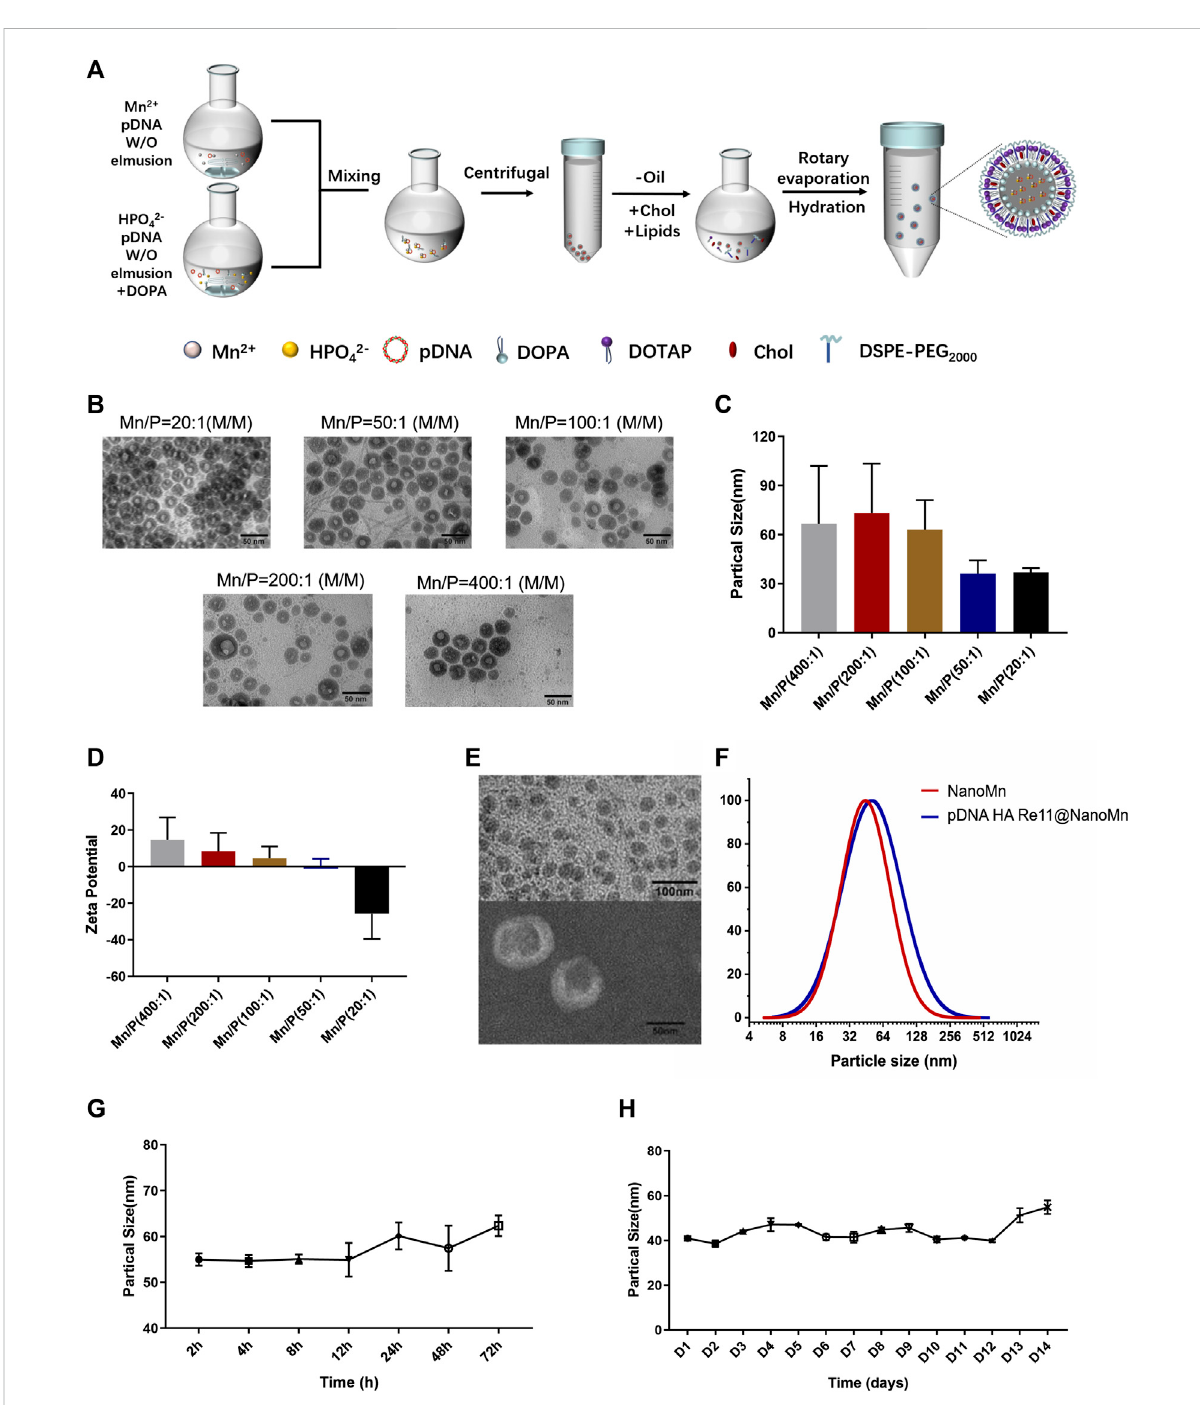
FIGURE 1 (A) Schematic diagram of the preparation process of pDNA HA Re11@NanoMn. (B) Inner core TEM image of pDNA HA Re11@NanoMn. (C) The particle size difference of pDNA HA Re11@NanoMn cores formed by different Mn/P molar ratios. (D) The Zeta potential differences of pDNA HA Re11@NanoMn cores formed by different Mn/P molar ratios. (E) TEM image of pDNA HA Re11@NanoMn. (F) Changes in particle size distribution of pDNA HA Re11@NanoMn and NanoMn. (G) Changes in particle size of pDNA HA Re11@NanoMn stored in PBS containing 10% FBS (37 ° C)